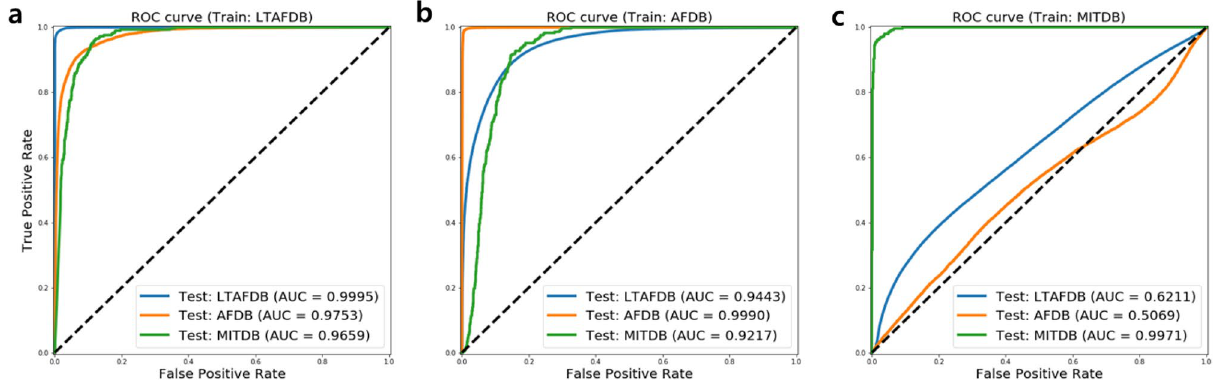
Figure 4. ROC curve of the Resnet 50 model for estimating data dependency. ( a ) The results of train model on LTAFDB. ( b ) The results of train model on AFDB. ( c ) The results of train model on MITDB.